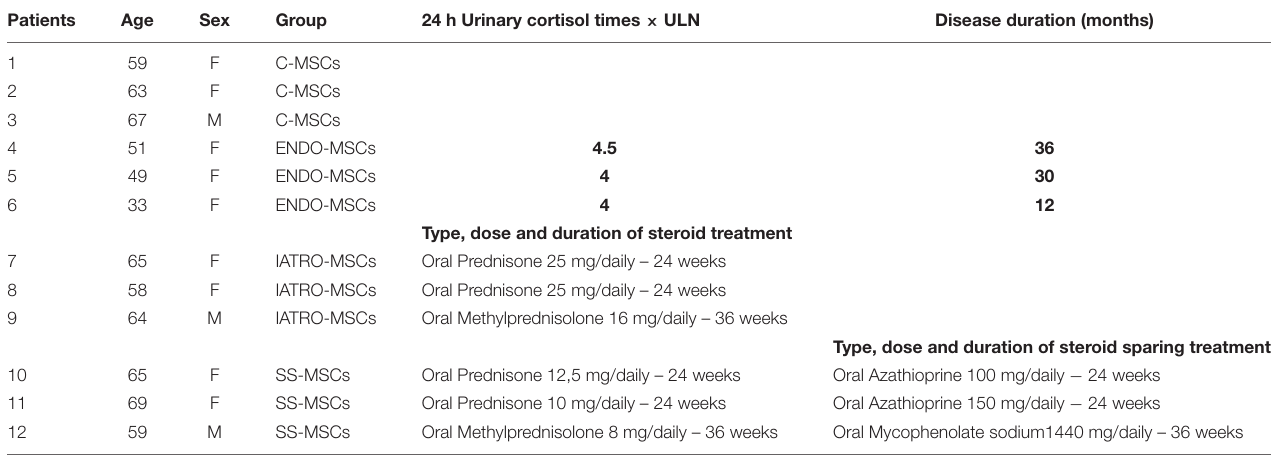
TABLE 1 | Demographic and treatment profile of enrolled